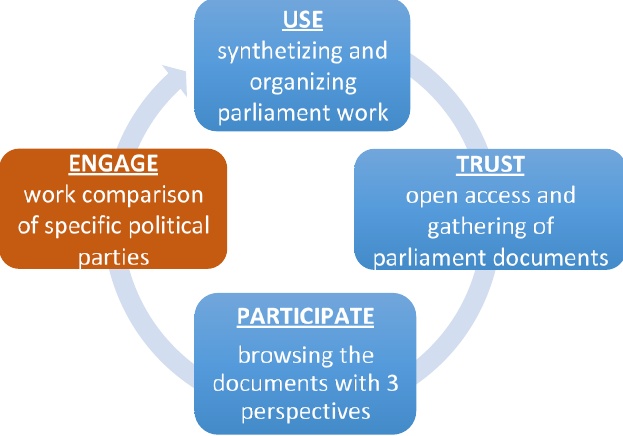
Figure 10. Legislative work visualization life cycle.